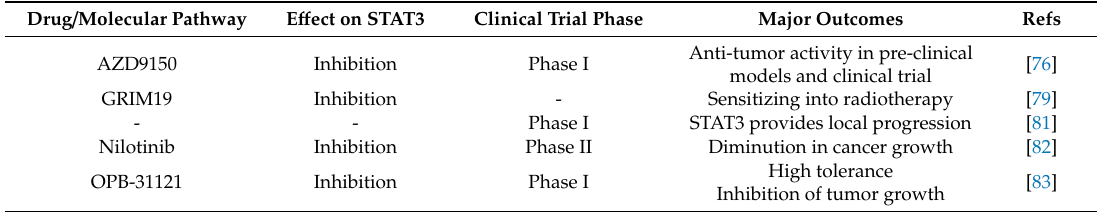
Table 2. Targeting STAT3 in cancer therapy in clinical